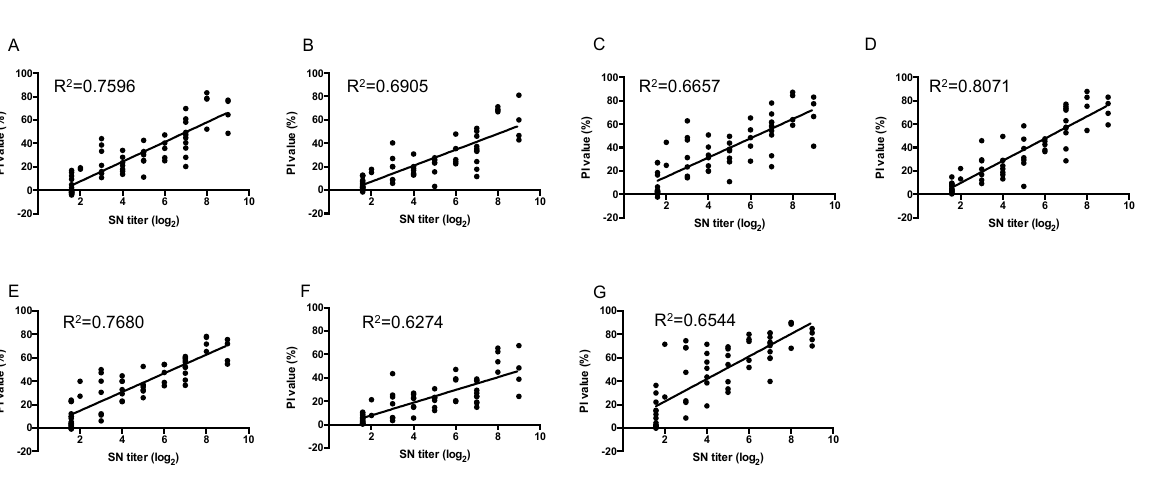
Figure 3. Scatter plots and calculated regression lines for SN titers and PI values as measured with solid-phase blocking ELISA based on VLPs ( A – D ) or GST-P1 ( E – G ). Results of VLP-based bELISA with tracers: ( A ) Q10EHRP, ( B ) P11A-HRP, ( C ) TSG-HRP, and ( D ) S11B-HRP. Results of P1-based bELISA with tracers: ( E ) Q10E-HRP, ( F ) P11A-HRP, and ( G ) TSG-HRP. Each test was performed in triplicate. Table 2. Comparison of the performance of bELISA with different tracers and antigens.